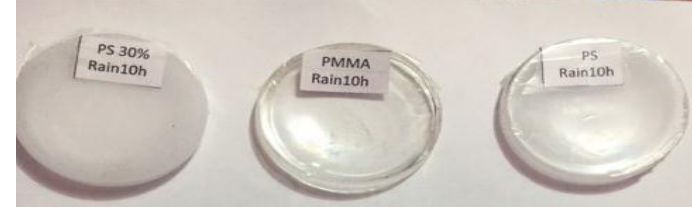
Fig.7: Shows 10hr rain for PMMA, PS, 30%PMMA\PS.